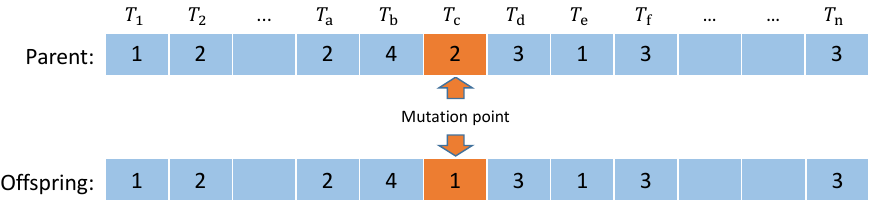
Figure 4. One-point mutation